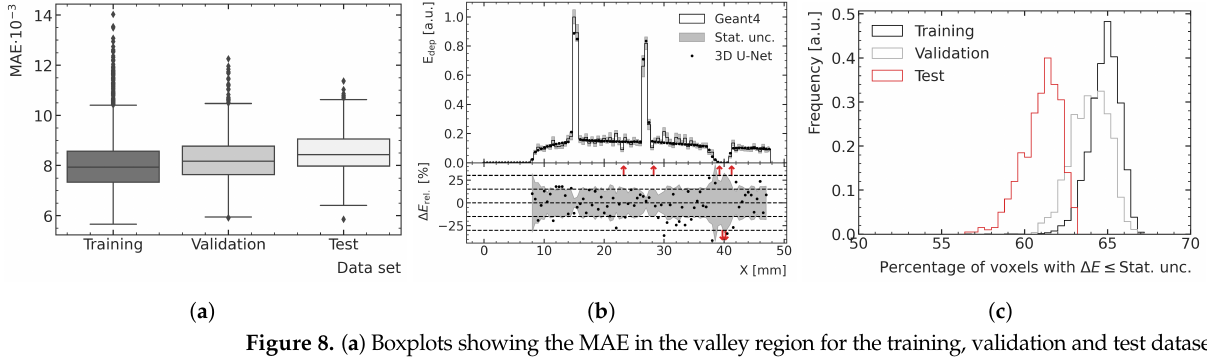
Figure 8. ( a ) Boxplots showing the MAE in the valley region for the training, validation and test datasets. The central line of the each boxplot shows the median of the distribution. The surrounding box is limited by the 25% percentile. The whiskers are shown at the 2.5 × 25% percentile. Data samples further away from the median are represented as outliers. ( b ) Exemplary ML-predicted and MC-simulated energy deposition E dep of the validation data in the valley region. The bottom plot shows the percent relative difference ∆ E rel between ML prediction and MC simulation in terms of energy deposition. Red arrows in the relative energy deviation subplot indicate deviations larger than the shown ranges. ( c ) Fraction of voxels of the ML-predicted energy deposition maps exhibiting a deviation of one standard deviation or less with respect to the mean energy deposition ∆ E calculated with the MC simulation.